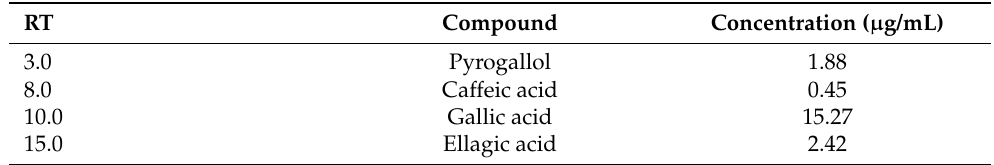
Table 3. HPLC chromatogram of phenolics from GB leaves.